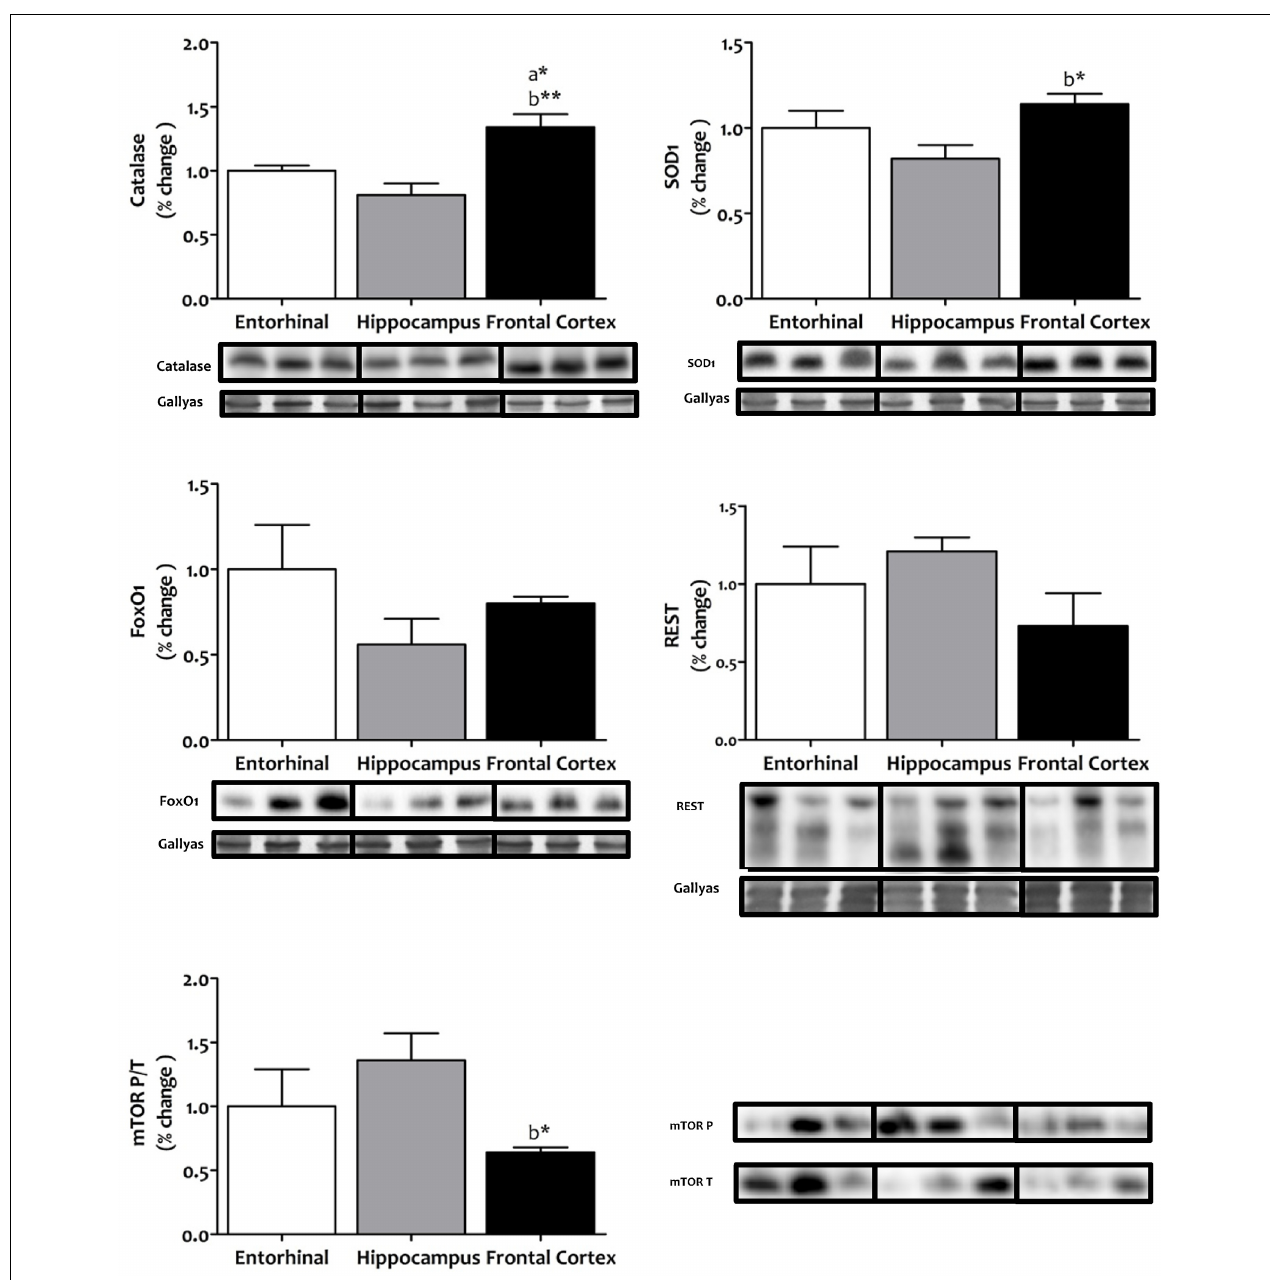
FIGURE 6 | Tissue protein expression of factors associated with stress resistance and cell survival in different regions of the adult human cerebral cortex. The antioxidants catalase and SOD1, the FOXO transcriptional factor FOXO1, the repressor element 1-silencing transcription factor REST, and the master regulator that senses cell nutrient and energy status, mechanistic target of rapamycin mTOR, where all determined with western blot. ∗ p < 0.05; ∗∗ p < 0.01; ∗∗∗ p < 0.001. a, significant differences with respect to entorhinal cortex; b, significant differences with respect to hippocampus. All western blots can be found as Supplementary Figure S1